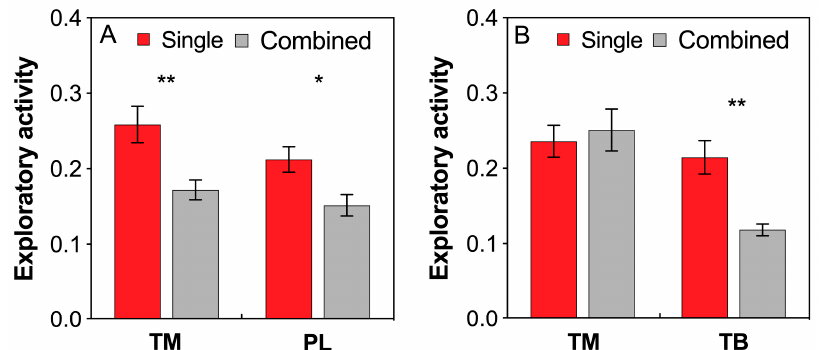
Figure 5. Effects of interference competition on ant exploratory activity. ( A ) T. melanocephalum - P. longicornis interaction; ( B ) T. melanocephalum - T. bicarinatum interaction. The data are presented as the mean ± SE. Asterisk (* or **) on bars indicates significant differences between the treatments ( P < 0.05 or P < 0.01). Tapinoma melanocephalum , Paratrechina longicornis and Tetramorium bicarinatum were abbreviated into TM, PL, and TB respectively.